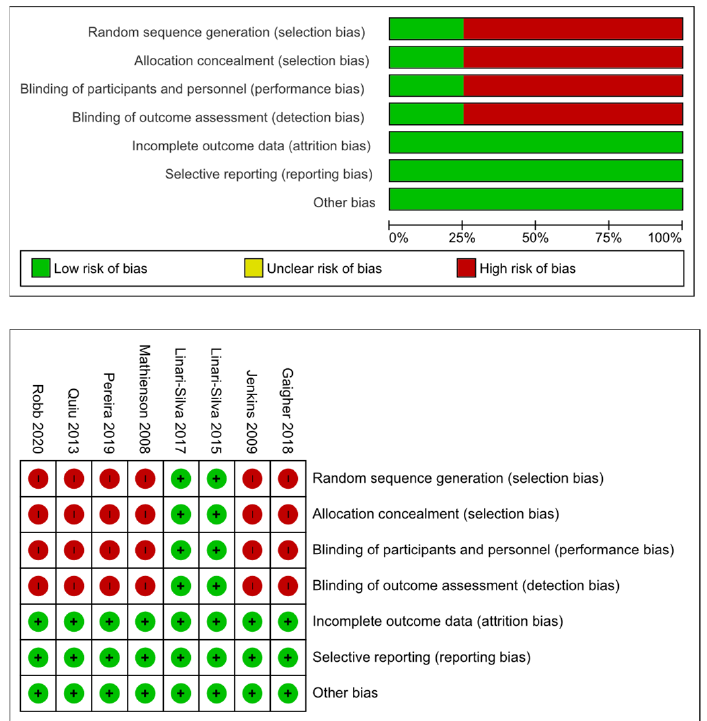
Figure 2. Risk of bias in the studies included. Green: Low risk of bias. Red: High risk of bias. Of the eight studies included, two were RCTs [8,16], and the other six were non-con- Table 2. Main characteristics of the studies included. trolled clinical trials [1,6,9,10,18,19]. The full number of participants in all the studies was 218 (102 men and 96 women; two studies did not specify the participants’ genders). The age ranged from 64.73 ± 7.66 to 85 years old. All the studies were conducted on adults. Interventions used were textured insoles [1,6,8,16–18], footwear modification [10], and ha- bitual footwear [9]. There were nine types of comparisons used: textured insole vs. basal [18], textured insoles vs. conventional insoles [1,6,8,16,18], footwear modification vs. basal [10], habitual footwear vs. barefoot [9]. These outcomes were evaluated in the different studies: gait parameters [1,8,10,16], balance [6,17], and plantar sensation [8,16].